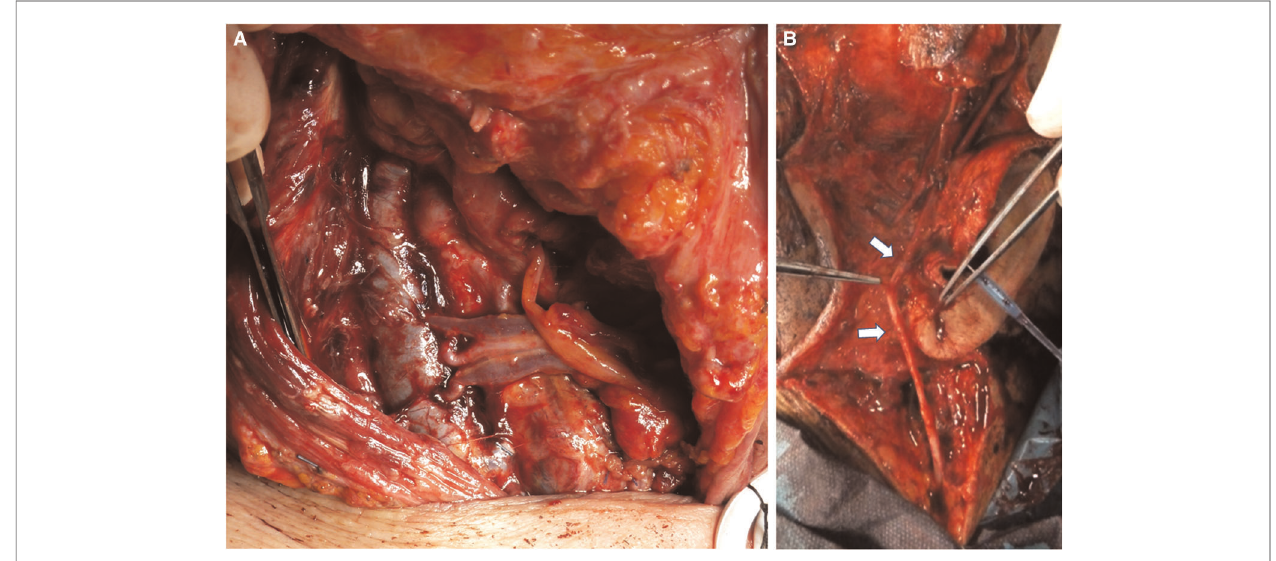
FIGURE 5 | Venous recipient vessel. ( A ) End-to-side double vein anastomosis between the internal jugular vein and the comitant veins of the gracilis fl ap pedicle. ( B ) Anastomosis with graft (white arrow) to the retromandibular tract of the external jugular vein freed from the